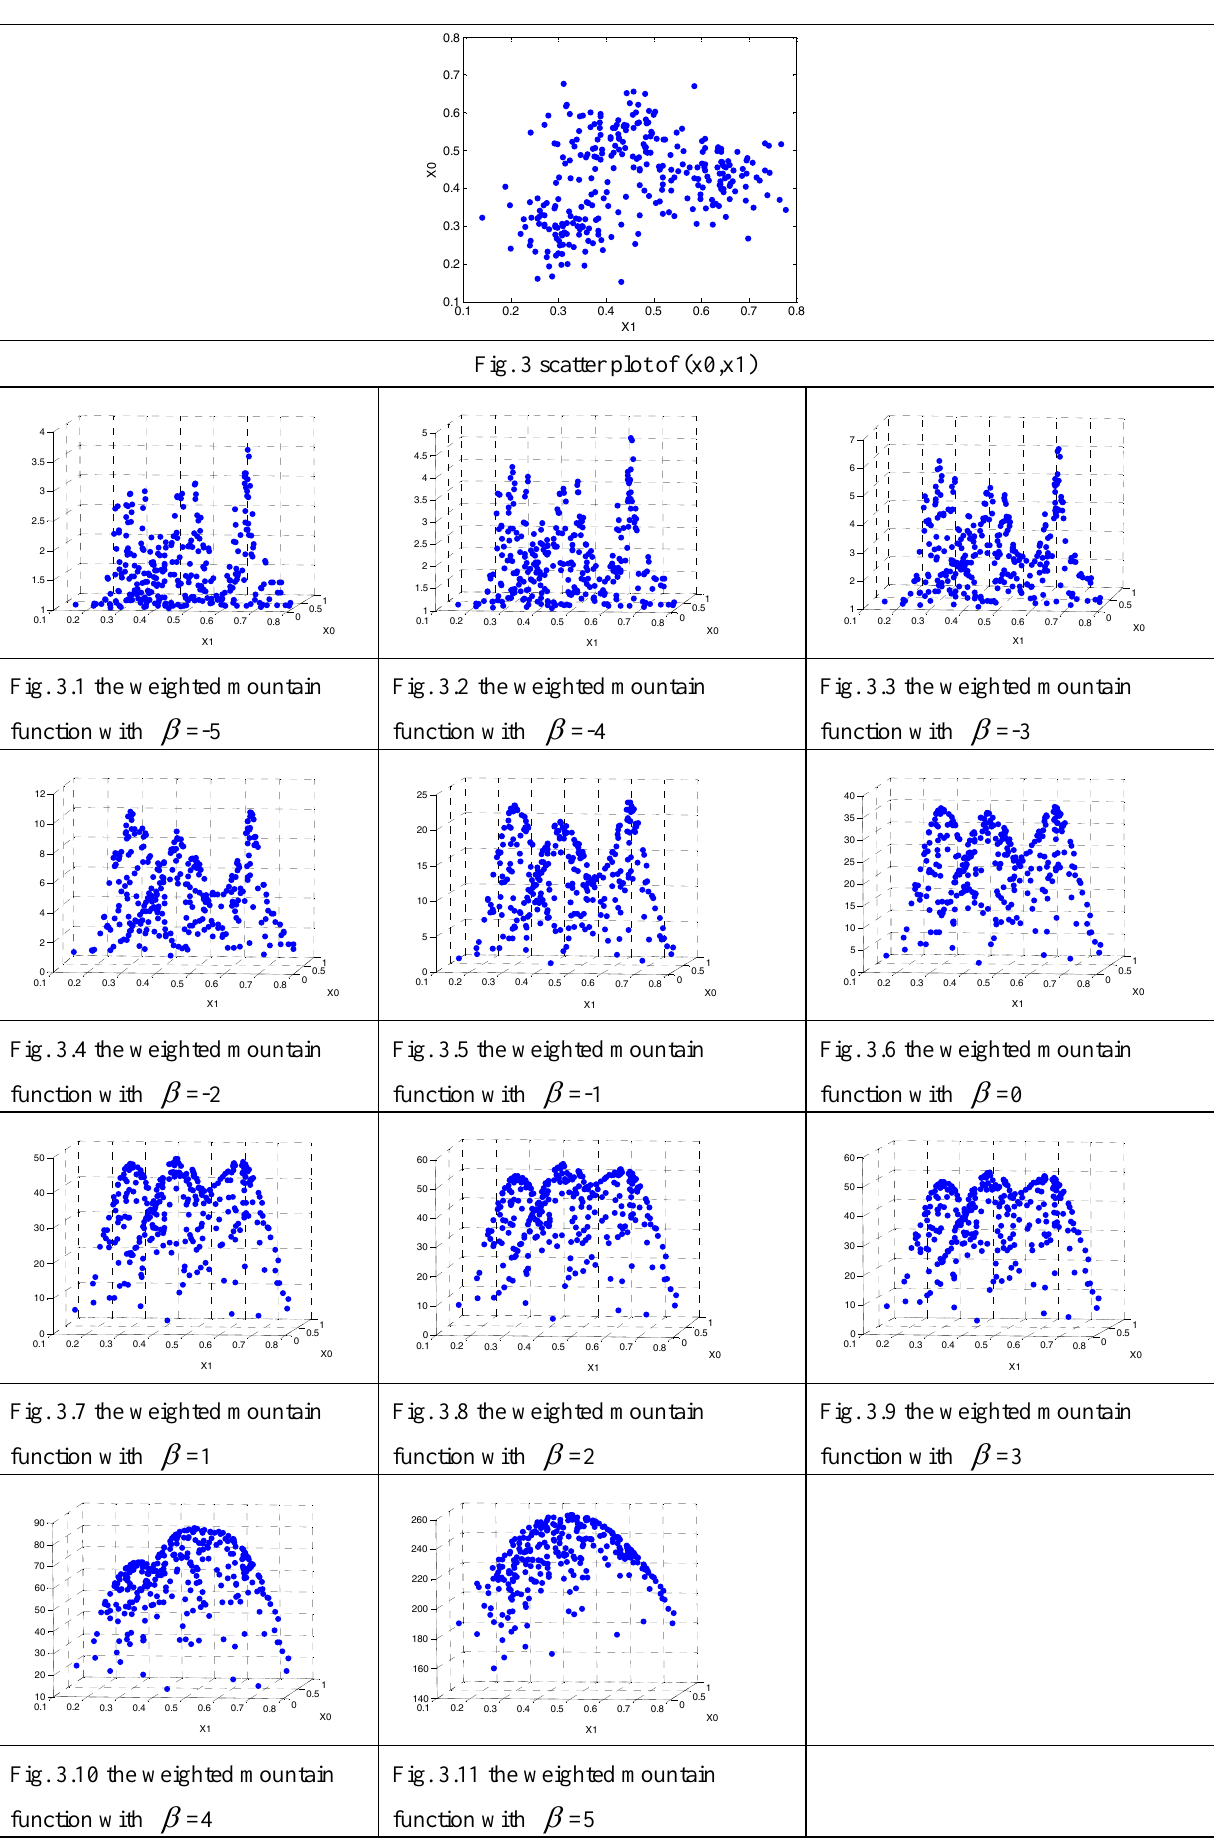
Fig. 3.10 the weighted mountain function with  =4